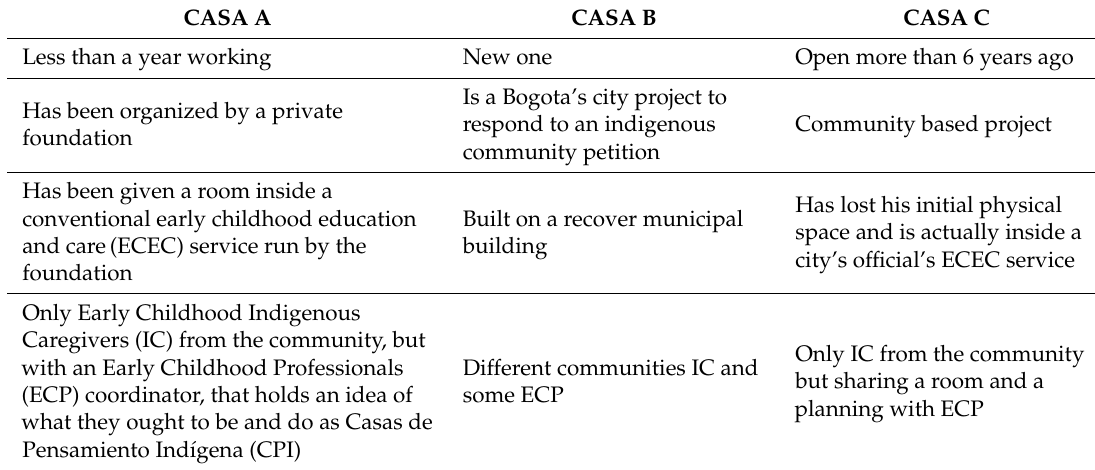
Table 1. List of the field and their particularities.